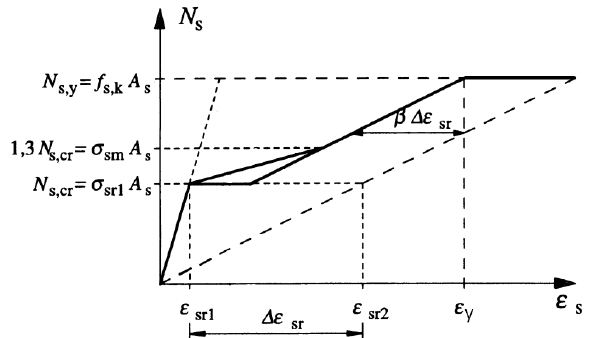
Figure 14: Tension stiffening model adopted in approach C according to annex L1